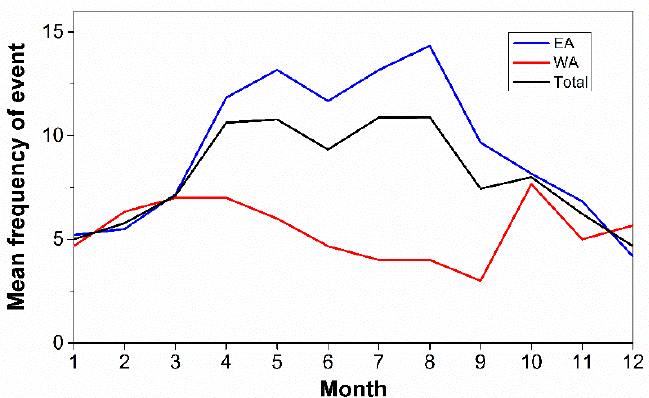
Figure 3. Monthly mean frequencies of high snow accumulation events in Antarctica (Total), East Antarctica (EA), and West Antarctica (WA). East Antarctica (EA), and West Antarctica